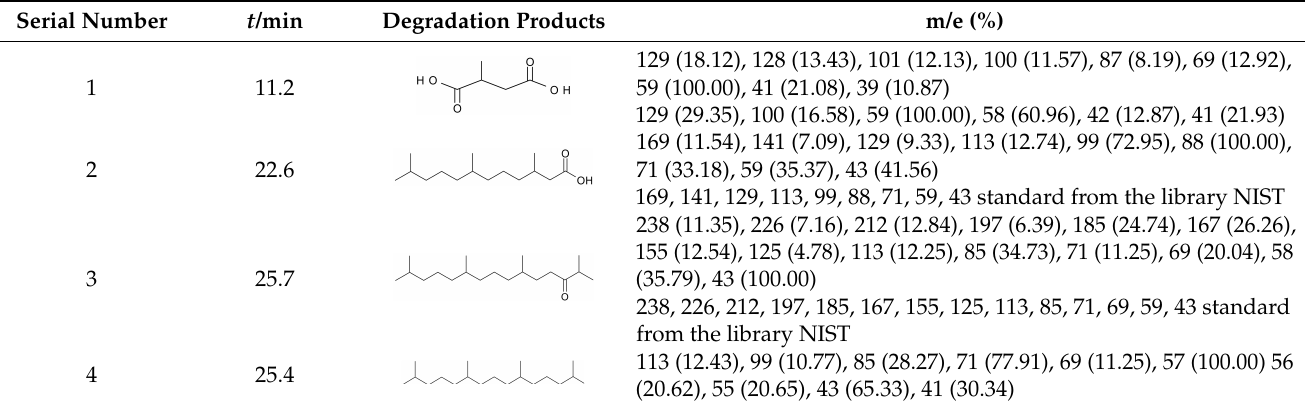
Table 2. Mass spectrometric data of compounds isolated during growth on pristane by strain